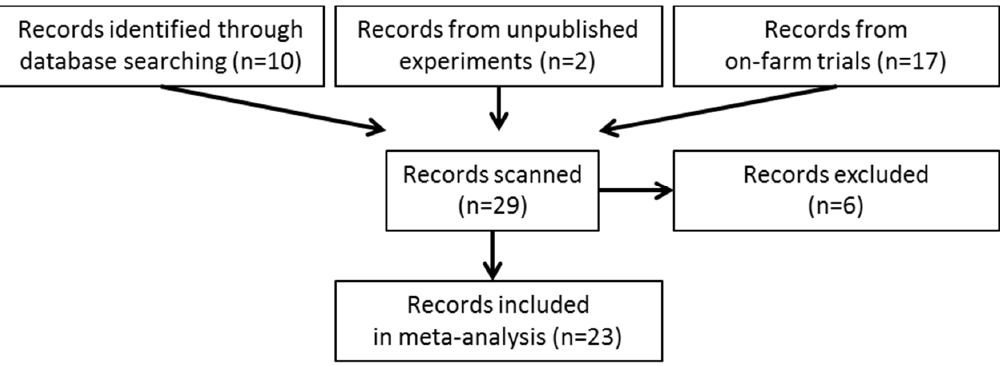
Figure 1. PRISMA flow diagram of all of the records searched and included in the meta-analysis.